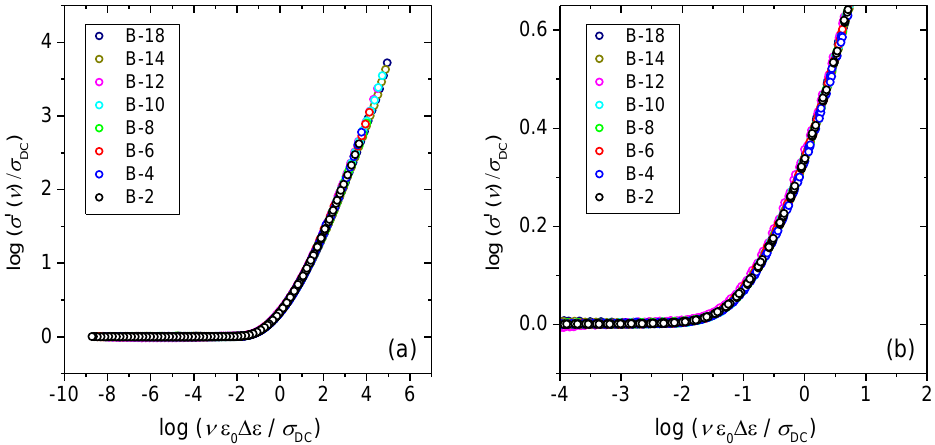
Figure 10. ( a ) Construction of super-master curve of the conductivity isotherms using Sidebottom scaling procedure for B-2 to B-18 glasses and ( b ) zoomed area to underline the observed overlap. B-20 glass is not plotted due to different shape of the conductivity dispersion.